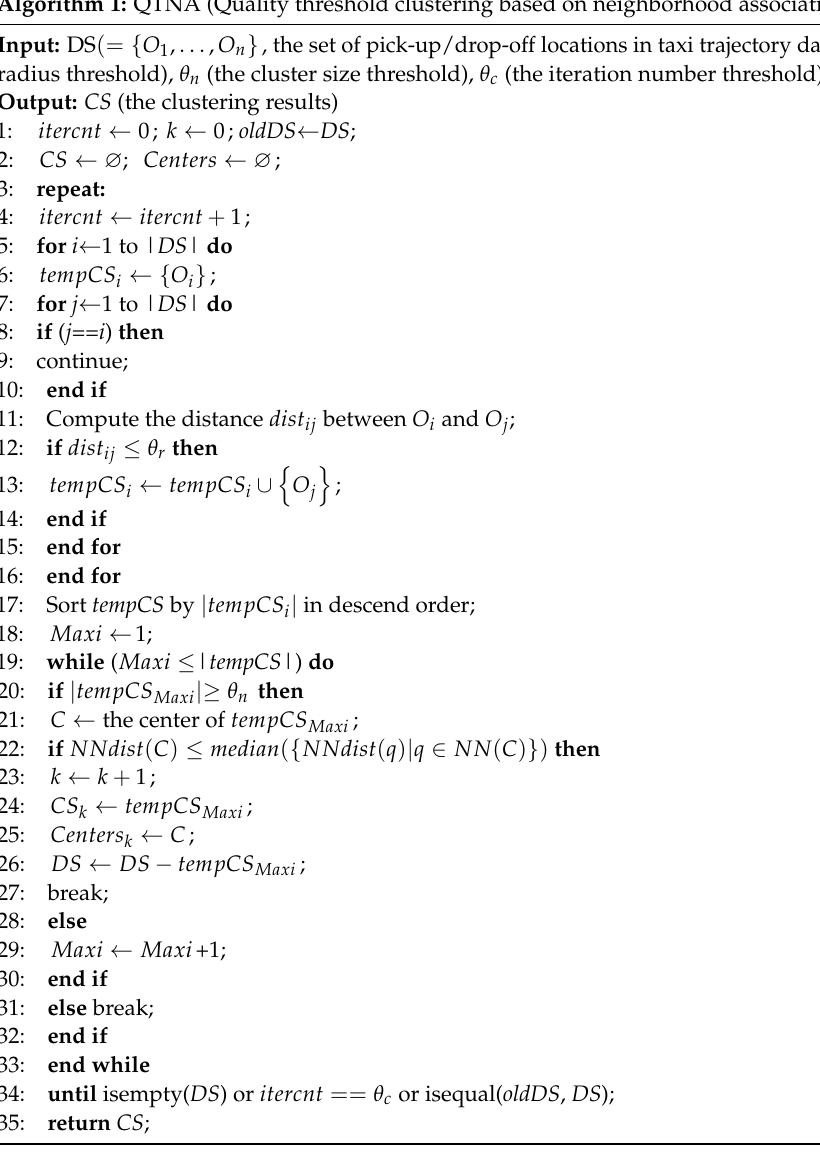
Algorithm 1: QTNA (Quality threshold clustering based on neighborhood